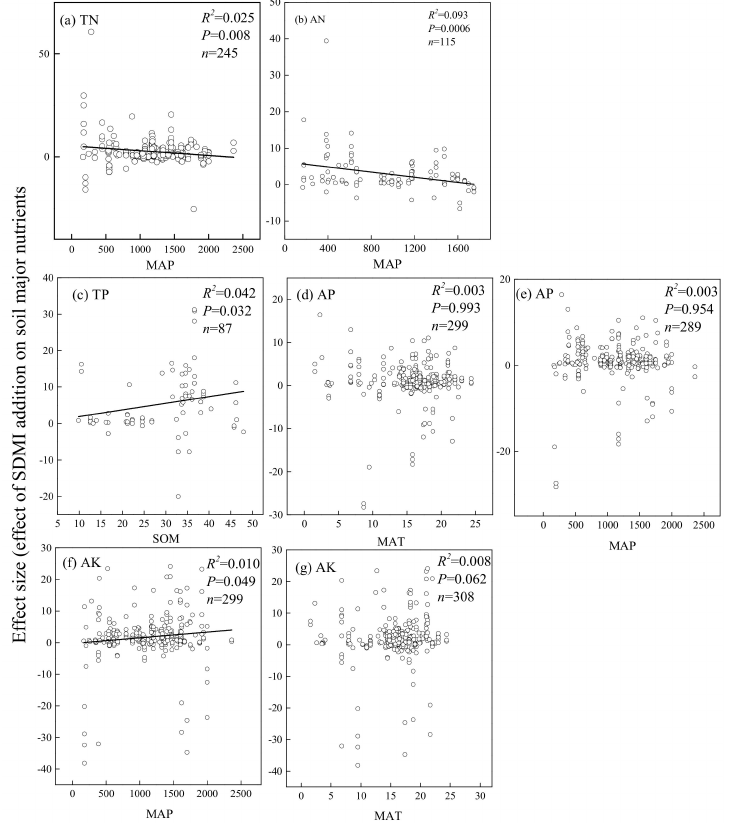
Figure 6. Simple linear regression to investigate the integrated effects of SDMI application and environmental variables on soil total N ( a ), available N ( b ), total P ( c ), available P ( d , e ), and available K ( f , g ). MAP: mean annual precipitation; MAT: mean annual temperature. The n represent the samples of the